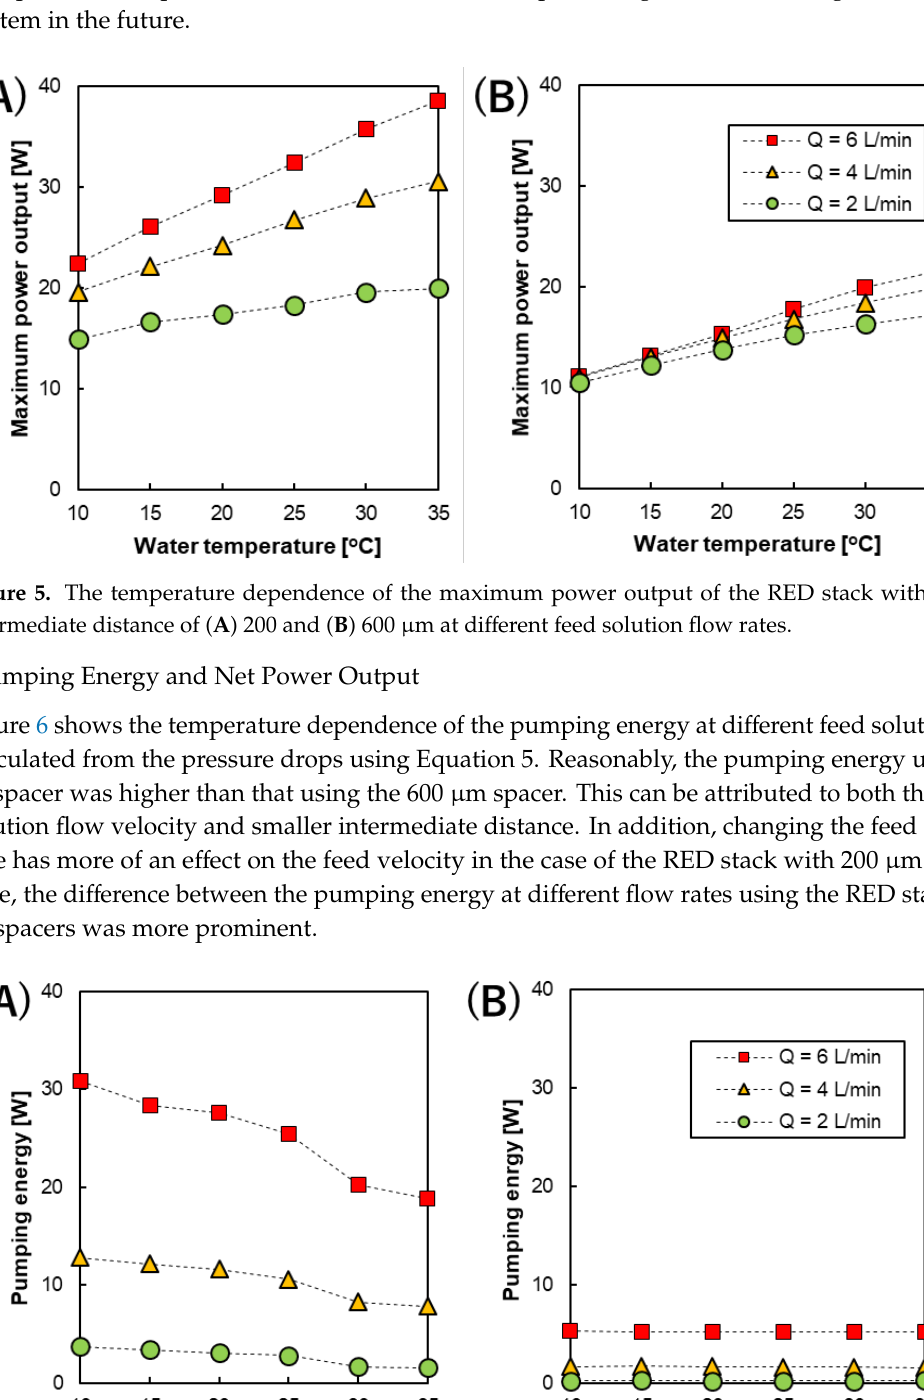
Figure 7 . The temperature dependence of the net power output of the RED stack with an intermediate distance of ( A ) 200 and ( B ) 600 µm at different flow rates. 4. Conclusions The effects of temperature on the solution and membrane resistance, and subsequent power generation performance of two pilot-scale RED stacks (200 and 600 µm) have been presented in this study. Both the solution and membrane resistance show linear temperature dependences of ~2.2 and 2.7%/°C, respectively. On the other hand, the temperature dependence of the RED stack OCV was ~0.2%/°C, which was independent of the intermediate distance. However, the subsequent power output and its temperature dependence were influenced by experimental conditions such as the flow rate and intermediate distance with a temperature coefficient of 1.1–2.0%/°C, which approaches its predicted value of ~3%. Furthermore, the net power output was dramatically influenced by temperature, especially in the case of the higher performance RED stack (smaller intermediate distance and high flow rate conditions). On the other hand, the temperature dependence of the resulting net power became less when using the lower performance stack (larger intermediate